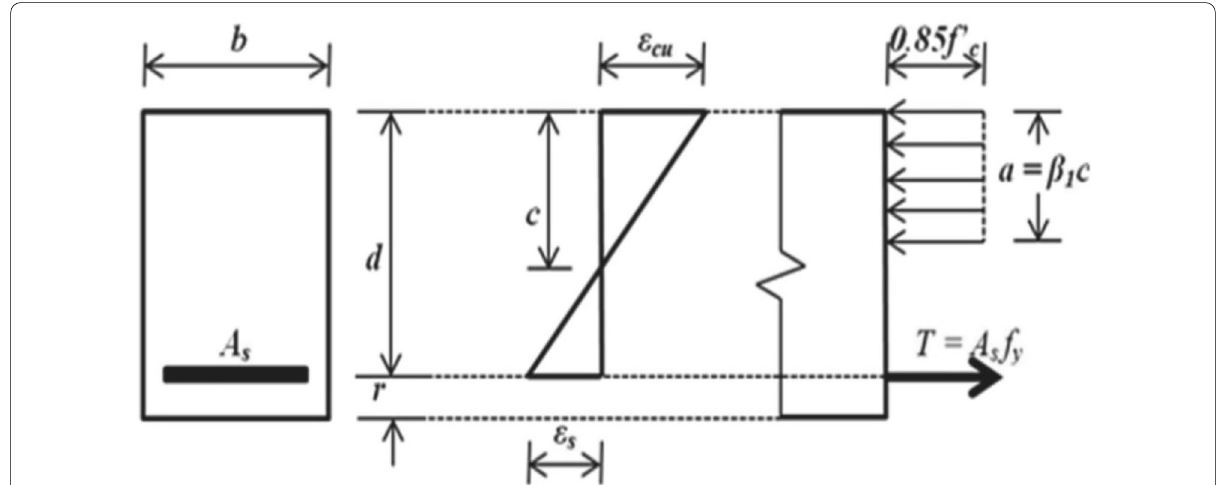
Fig. 19 Stress and strain distribution acting on RC beam section.